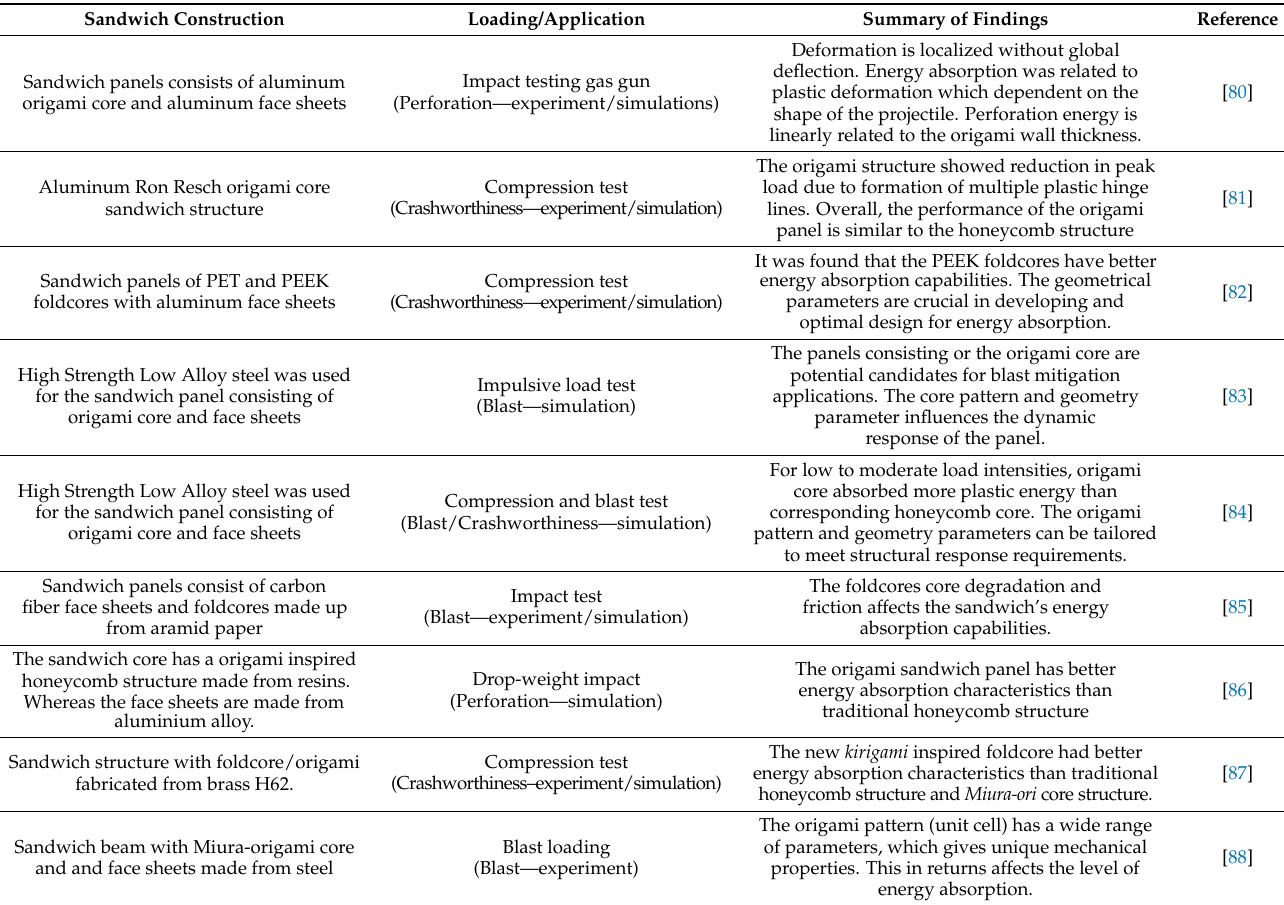
Table 5. Sandwich structure with